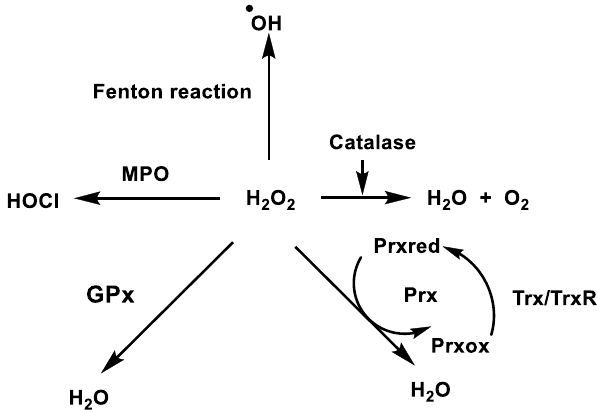
Figure 12. Enzymatic removal of hydrogen peroxide in biological systems.